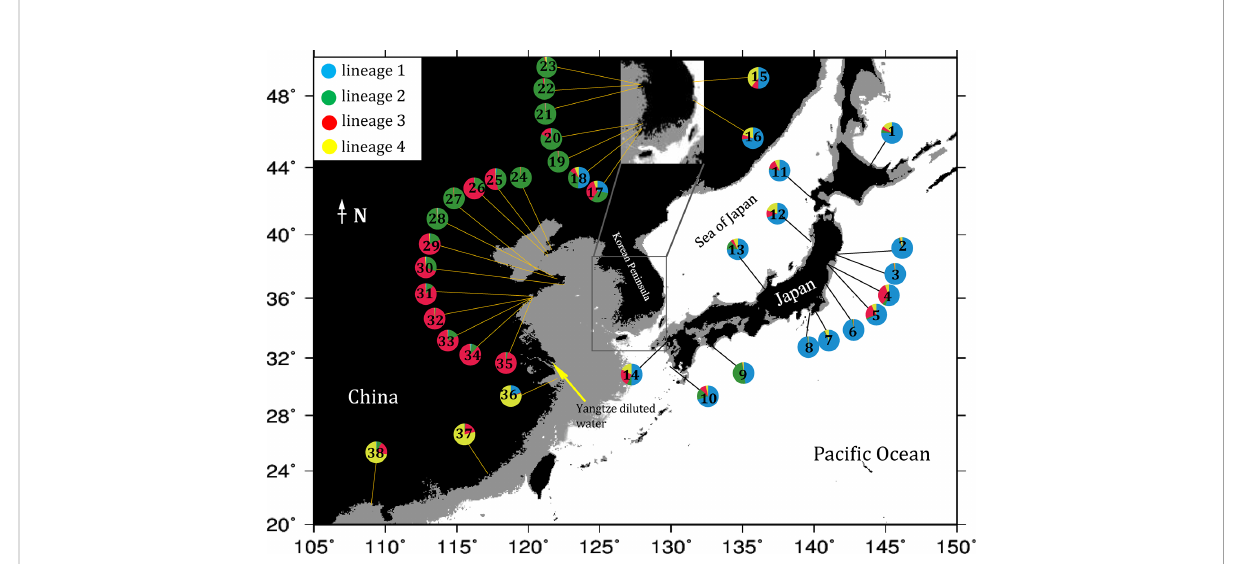
FIGURE 3 Geographical distribution of genetic lineages of G. vermiculophylla in the northwest Paci fi c identi fi ed by microsatellite genotyping. Numbers in pie charts correspond to sampling localities in Table 1. Colors corresponds to the lineages indicated in the structuring analysis (K = 4). The black areas represent the elevation >0 m, the gray areas represent the depth of water <130 m, and the light blue areas represent the depth of water >130 m (sea levels during the LGM).